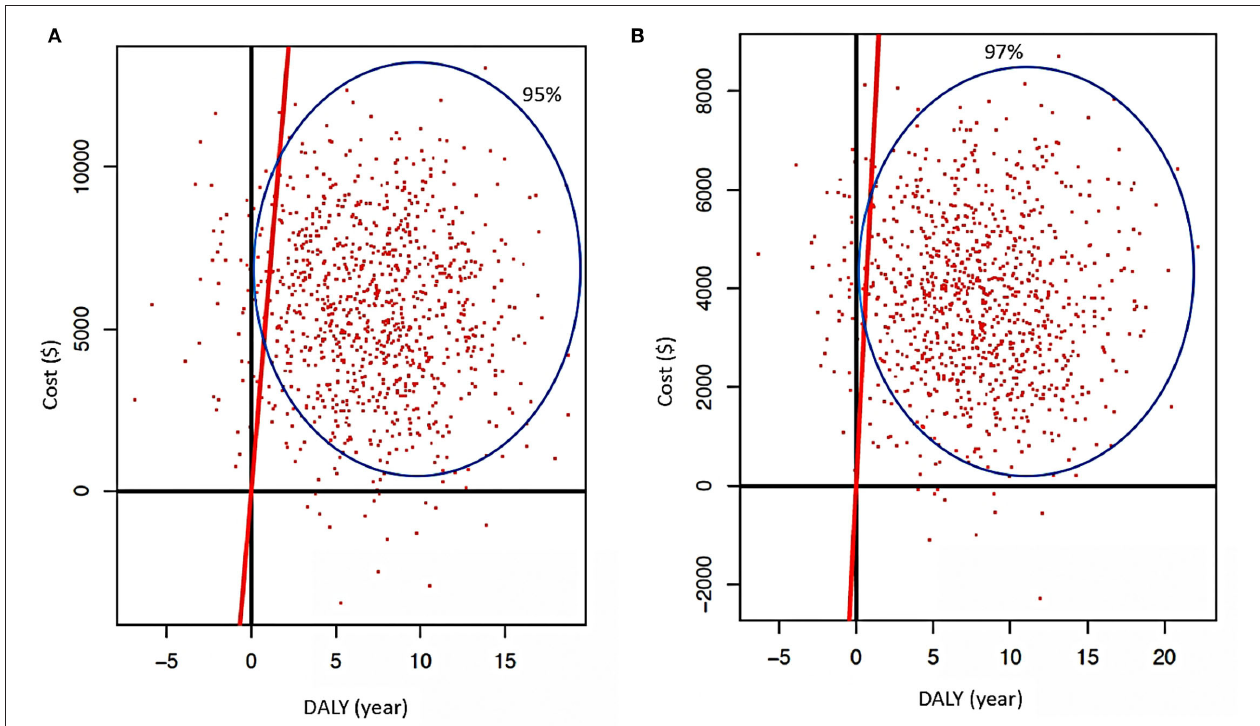
FIGURE 3 | (A) Cartesian plane representing PSA when ART is used as treatment without other intervention (traditional) is applied with deterministic data. (B) Results of PSA when ART is used (regular) using stochastic data (red continuous line represents GDP’s threshold; cost is in American dollars and DALYs in years).